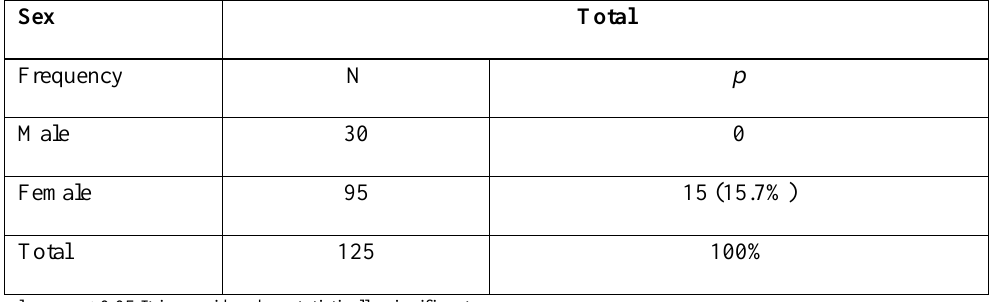
Table 2. Distribution of Trichomonas vaginalis among Sudanese patients according to sex.